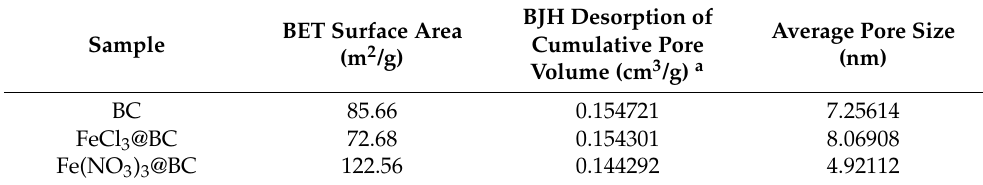
Table 1. The surface area and porosity of non-modified biochar (BC) and metal-based biochar (FeCl 3 @BC and Fe(NO 3 ) 3 @BC).